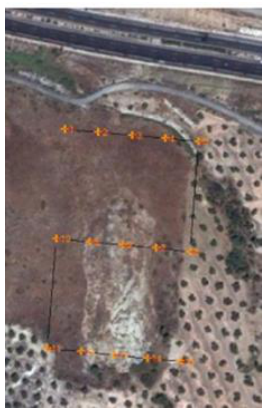
Figure 4. Planning of UAV flight.